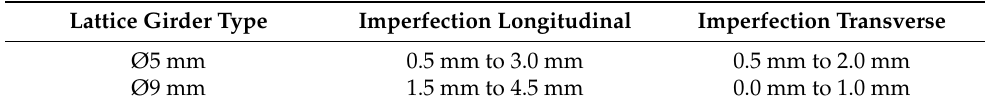
Table 2. Measured imperfections at the lattice girders.